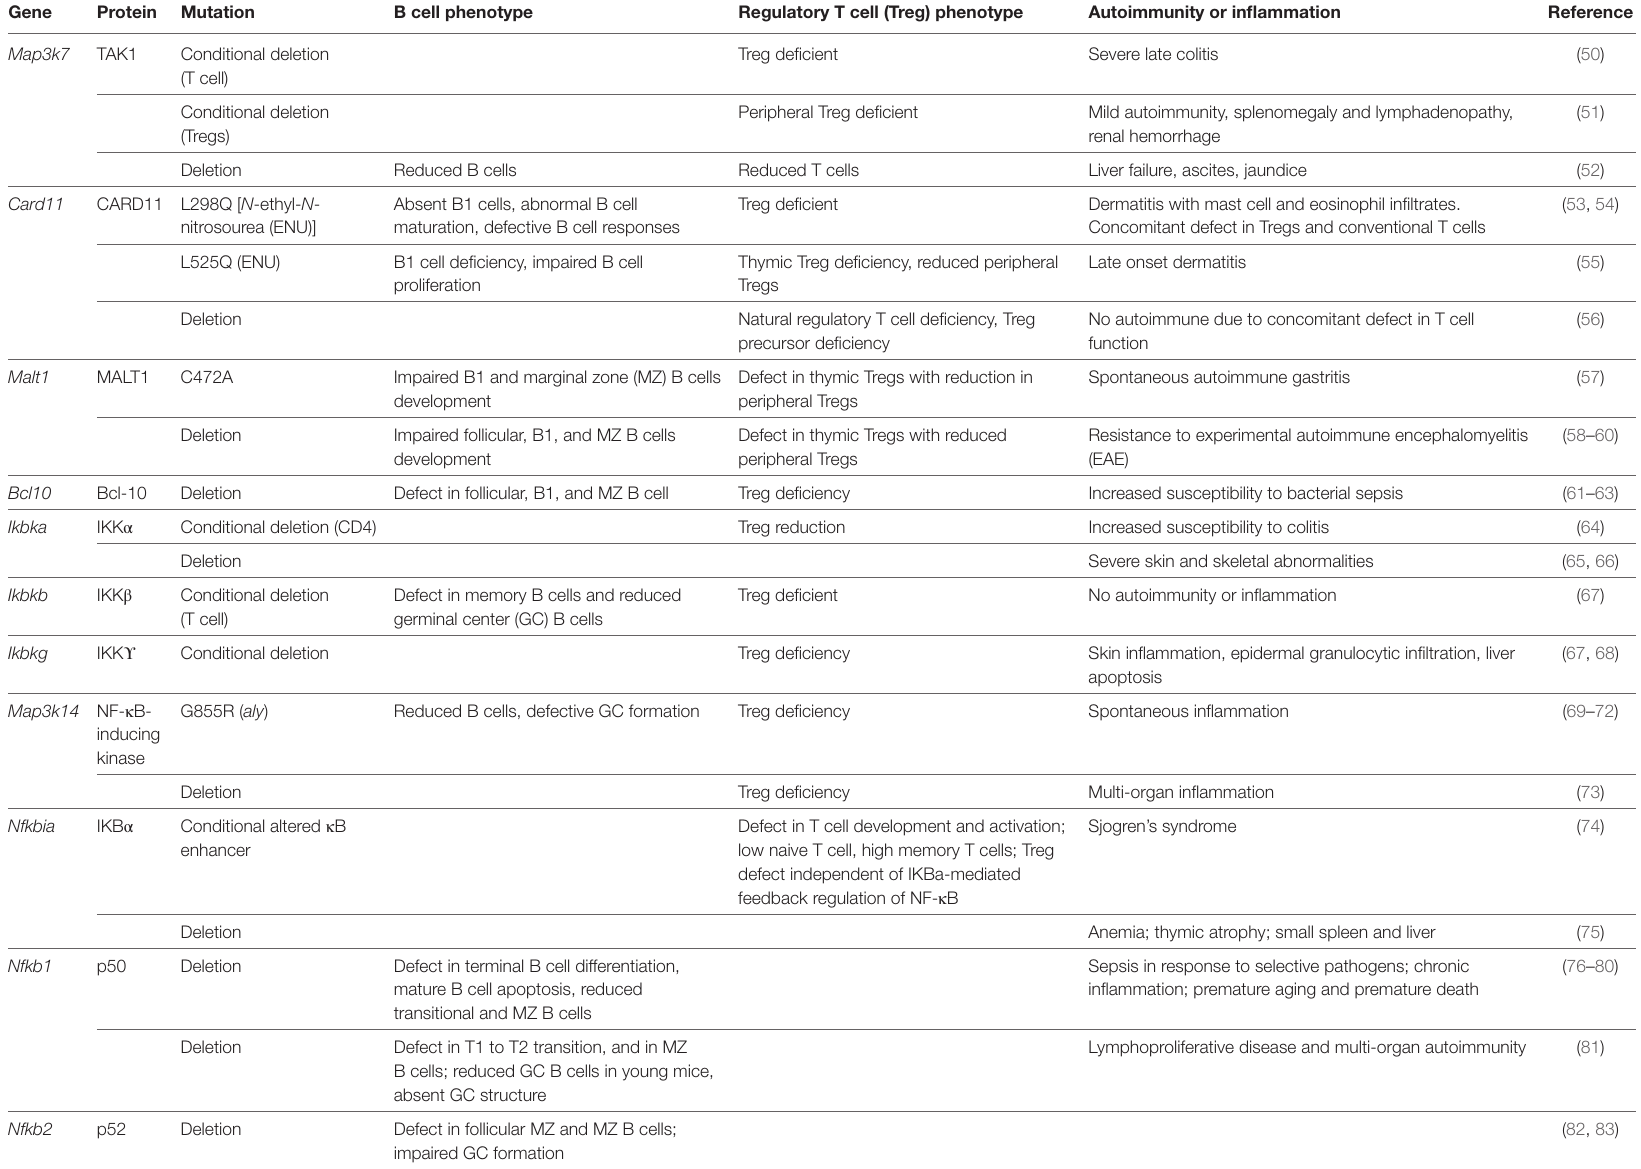
TABLe 1 | Summary of autoimmune phenotypes in mice with genetic manipulation of NF- κ B.